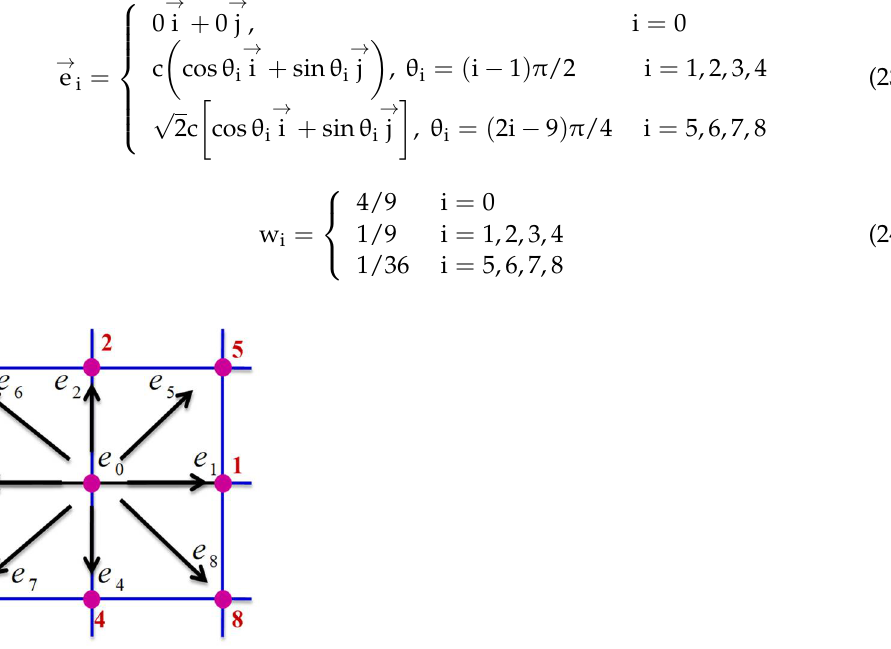
Figure 2. D2Q9 model. Note that the pink circles are the clusters particles’ sites particles, the black arrows indicate the propagation directions, while the blue lines are the distances between sites.